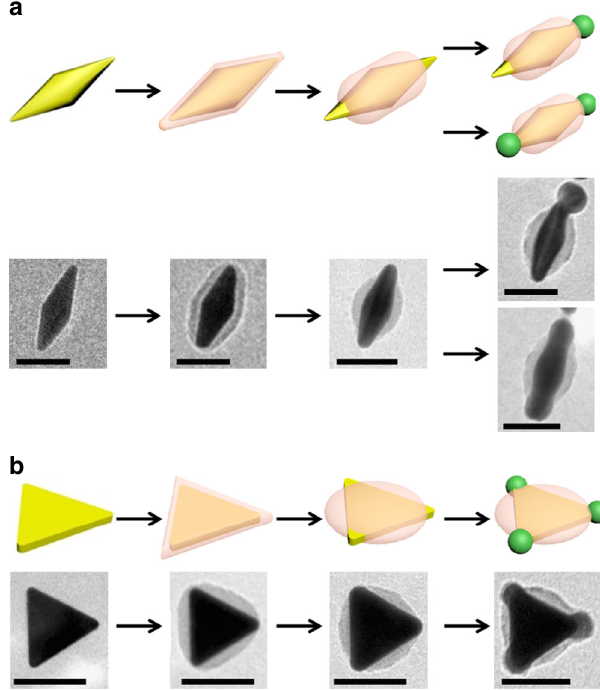
Fig. 7 Bipyramids and triangular nanoprisms. a , b Schematics and TEM images illustrating the encapsulation and contraction of PSPAA on Au bipyramids a and Au nanoprisms b , and the corresponding Ag deposition, respectively. The ligand used in this experiment is ligand- 1 . The scale bars are 50